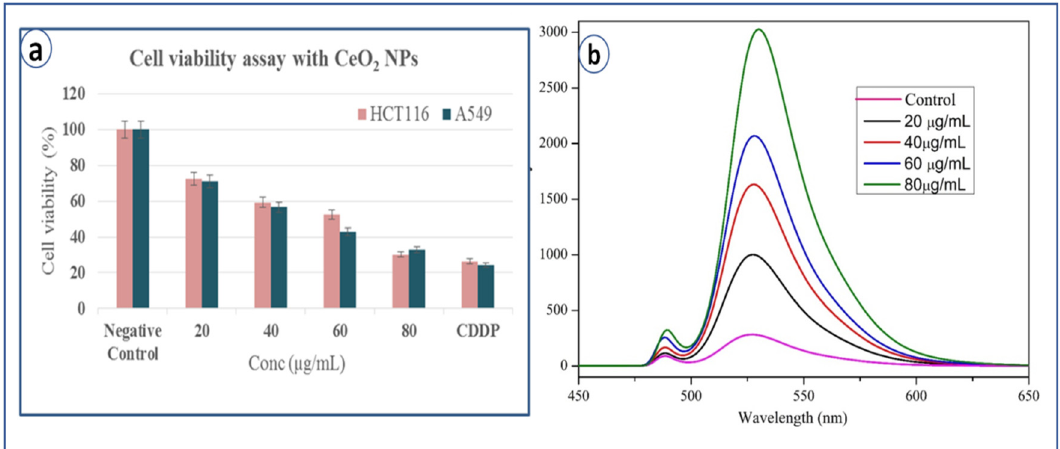
Figure 7. ( a ) Cell viability test by MTT assay with CeO 2 NPs, ( b ) ROS emission spectra of control and Figure 7. (a) Cell viability test by MTT assay with CeO 2 NPs, (b) ROS emission spectra of control and CeO 2 CeO 2 NPs.